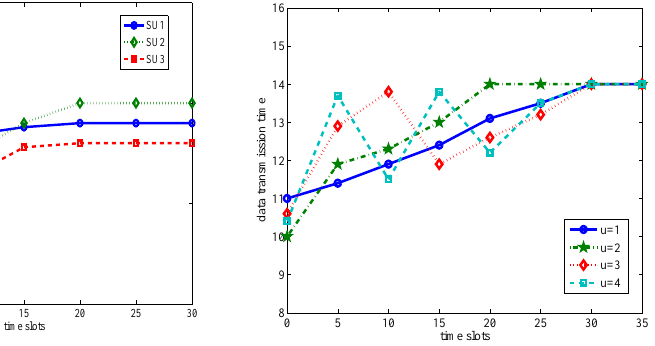
Figure 12. Convergence under different u .